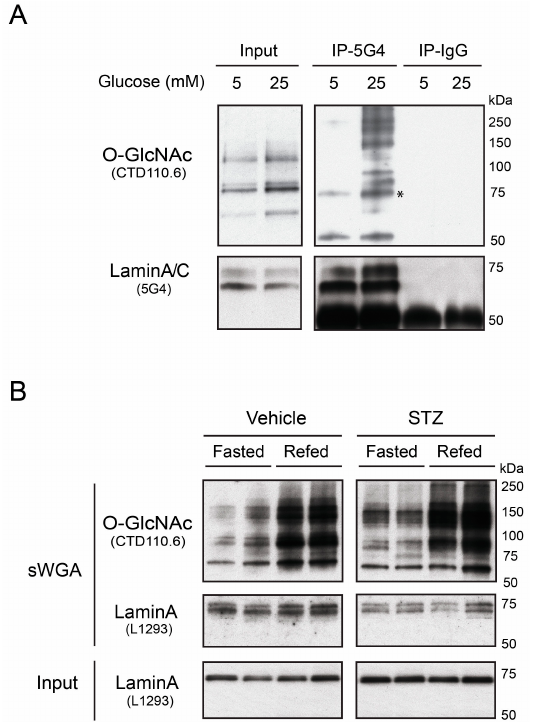
Figure 1. O -GlcNAcylation of native lamin A in human hepatoma (Huh7) cells and mouse liver. ( A ) Western blots of proteins from human hepatoma (Huh7) cells, cultured for 24 h in physiological (5 mM) or high (25 mM) glucose, probed with antibody CTD 110.6 specific for the β - O -linked N - acetylglucosamine modification ( O -GlcNAc), and then stripped and re-probed with antibody 5G4, specific for lamins A and C (Lamin A/C). Control input lysates, and proteins immunoprecipitated using lamin A/C antibody 5G4 or nonspecific IgG as the negative control, were resolved in parallel gels. Asterisk indicates the O -GlcNAc signal corresponding to immunoprecipitated lamin A; ( B ) Western blots of mouse liver nuclear proteins, before (Input) or after affinity purification on succinylated Wheat Germ Agglutinin (sWGA), which binds O -GlcNAc-modified proteins. We analyzed two livers for each condition. Male mice were either fasted (Fasted), or fasted and then re- fed for 12 h (‘Refed’), and were either pretreated with streptozotocin to induce hyperglycemia (‘STZ’), or not (‘Vehicle’). Input controls were probed with lamin A-specific antibody L1293. Affinity-purified samples were probed first for the O -GlcNAc modification (antibody CTD 110.6 ), and then stripped and re-probed for lamin A (antibody L1293). STZ—streptozocin.